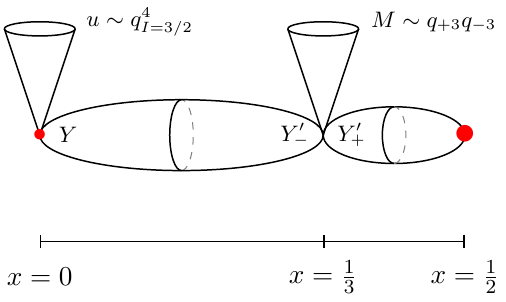
Figure 2 . The perturbative vacuum moduli space of the compacti(cid:12)ed ISS model. The cones represent the classical Higgs branches. The perturbative Coulomb branch shrinks near the points x = 0 ; 1 = 3 ; 1 = 2 where charged (cid:12)elds become massless. The red neighborhoods are where strong- coupling e(cid:11)ects are expected to undermine semi-classical